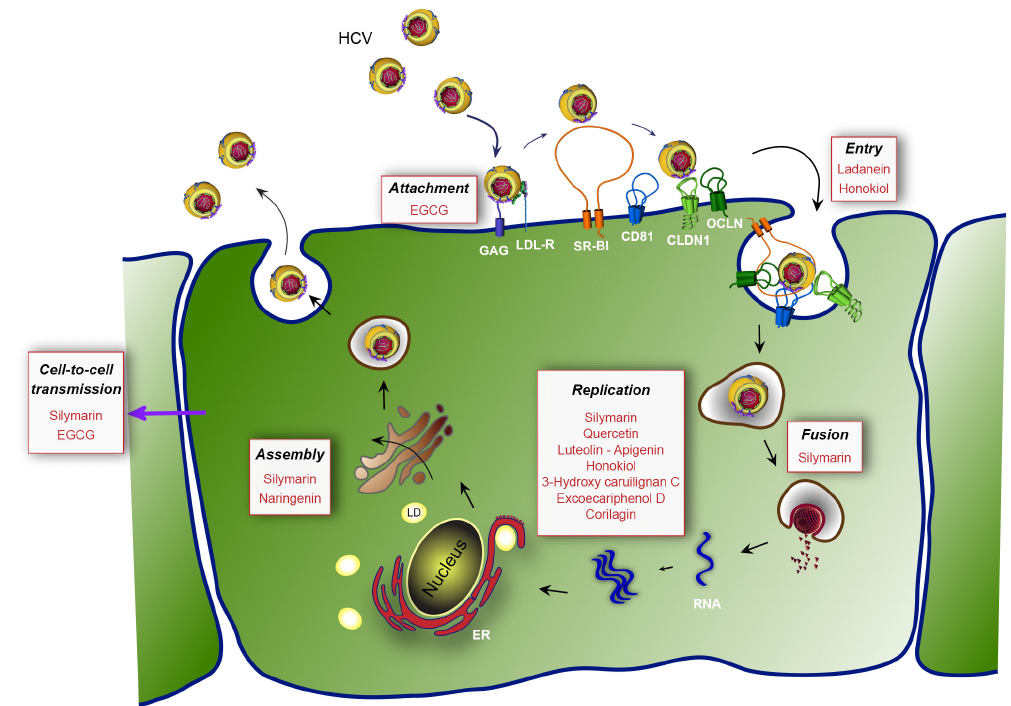
Figure 1. Hepatitis C virus (HCV) life cycle and targets of the most potent natural inhibitors. First, HCV binds to non-specific factors glycosaminoglycans (GAG) and LDL receptor (LDL-R) present at the cell surface (attachment step). Then, the viral particle is directed to specific entry factors (entry step), the scavenger receptor class B type I (SR-BI), the tetraspanin CD81 and the tight junction proteins claudin-1 (CLDN1) and occludin (OCLN). The virus is internalized by endocytosis and the viral genome is released into the cytosol of the cell after fusion with endosomes (fusion step). Next, the translation and the polyprotein processing take place and RNA is replicated (replication step). In the late stages of the cycle, the virion is assembled (assembly step) in the vicinity of cytoplasmic lipid droplets (LD) and is released from the cell. Finally, the released virions can infect adjacent cells by cell-free transmission or cell-to-cell transmission. The affected steps of the viral cycle are in black. The natural compounds are in red. EGCG: epigallocatechin- 3 - gallate; ER: endoplamic